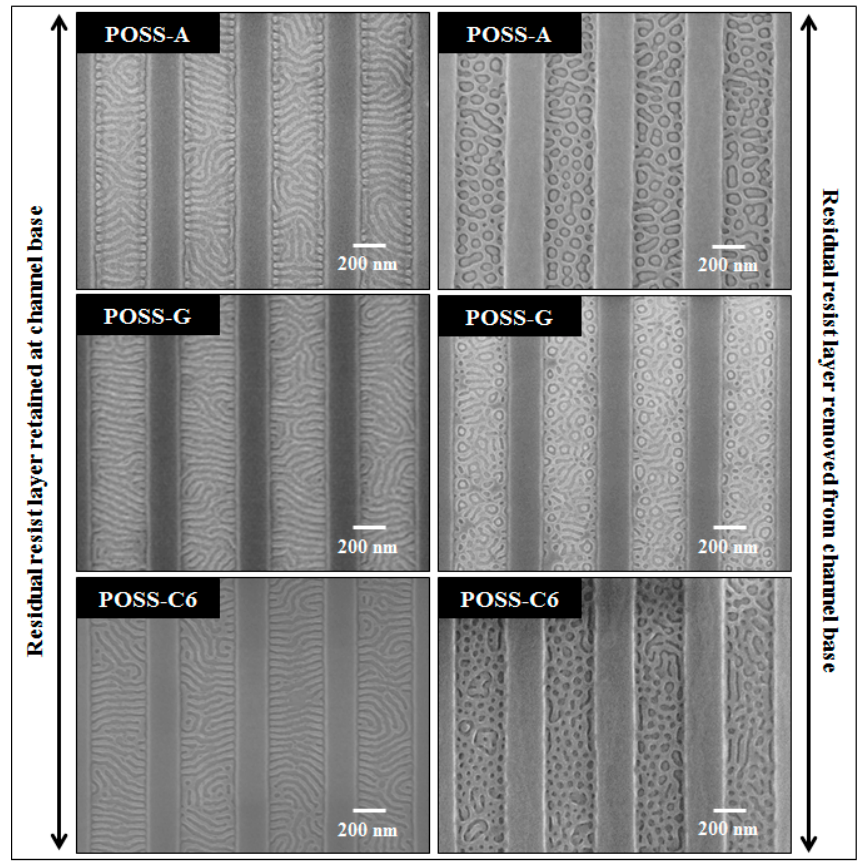
Figure 3. Top-down SEM images of lamellar-forming PS- b -PDMS at topographical POSS substrates before and after residual resist layer removal and following ETCH1.